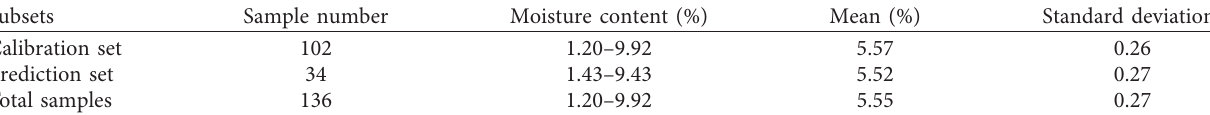
Table 1: The moisture content of walnut kernel samples.